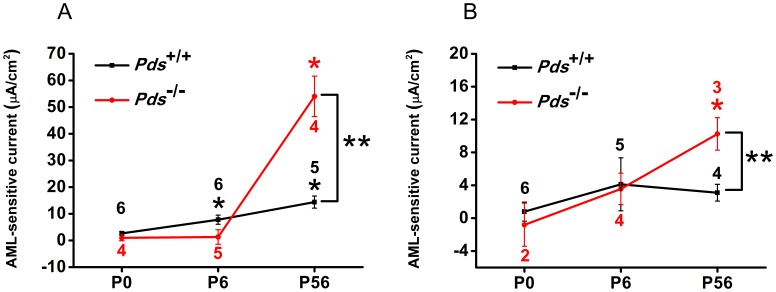
Difference of ENaC-dependent trans-epithelial current in Reissner’s membrane (A) and the extramacular roof epithelium of the saccule (B) at P0, P6, and P56.The ENaC-dependent current in Reissner’s membrane of Pds+/+ and Pds−/− mice was significantly increased according to the development The current was not changed in saccular extramacular membrane of Pds+/+ mice according to the development, but it was significantly increased at P56 of Pds−/− mice. The current difference between Pds+/+ and Pds−/− mice was significant at P56 both in Reissner’s membreane and saccular extramacular membrane. [p<0.05 (One Way ANOVA with Holm-Sidak post-test) at P6 and P56 of Pds+/+ mice and p<0.05 (One Way ANOVA with Dunn’s post-test) at P56 of Pds−/− mice]. *p<0.05 in the current difference among P0, P6, and P56 groups for each genotype (One Way ANOVA with Holm-Sidak/Dunn’s post-test), **P<0.05 in the current density differences between Pds+/+ and Pds−/− mice at P0, P6, and P56 (Mann-Whitney Rank Sum test), numbers above the bars represent the number of trans-epithelial current measurements.